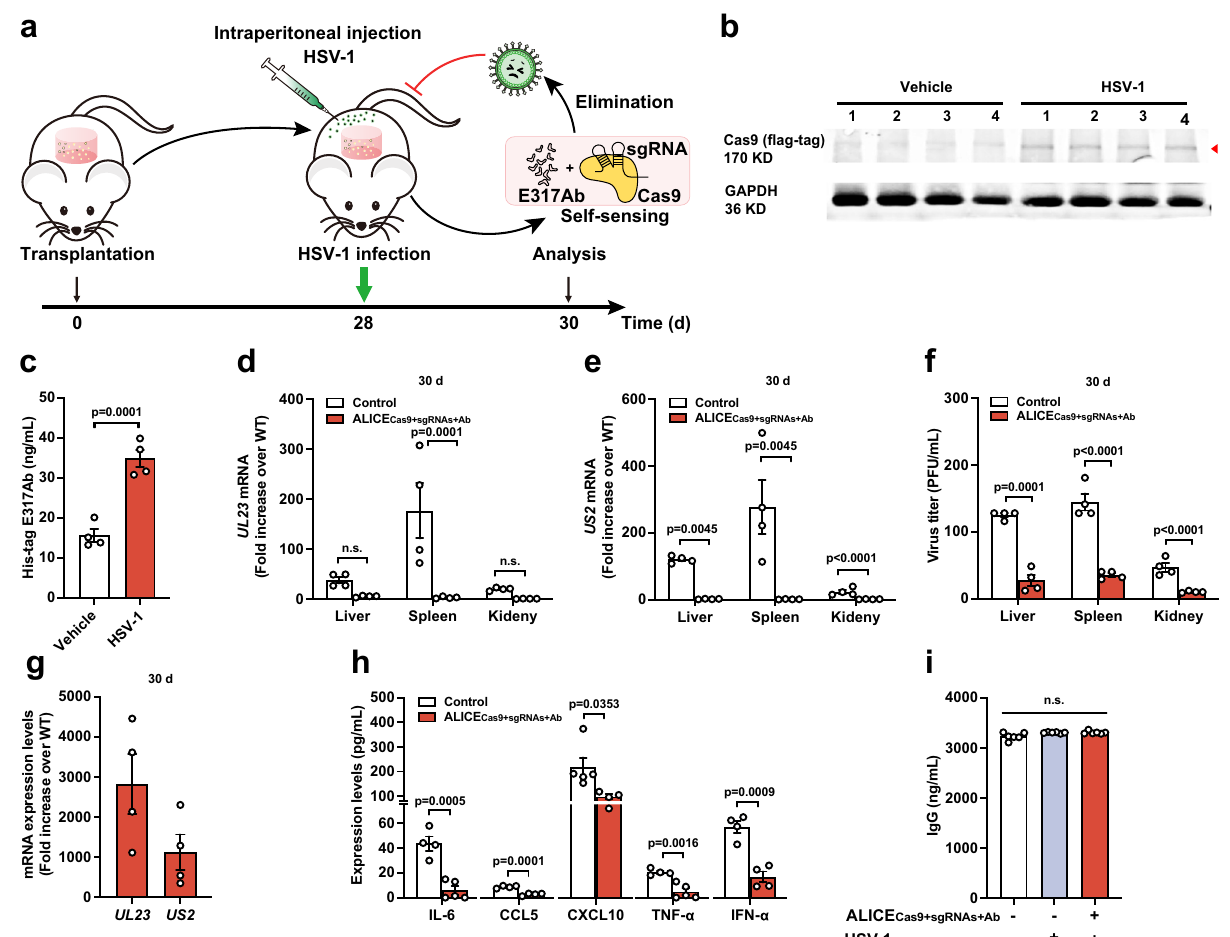
Fig. 5 | Long-term sense-and-destroy against HSV-1 mediated by ALICE Cas9+sgRNAs+Ab inmice.a SchematicillustrationofALICE Cas9+sgRNAs+Ab system for autonomous sense-and-destroy against HSV-1 in mice. HEK-293T cells stably integrated with ALICE Cas9+sgRNAs+Ab (HEK ALICE-Cas9-sgRNAs-E317Ab cells) or pcDNA3.1- transgenic HEK-293T cells (Control) were encapsulated into hydrogel-based scaf- folds and transplanted into mice abdomens via intraperitoneal surgery. At 28 d post-transplantation, HSV-1 (2×10 7 PFU) was intraperitoneally injected into each mouse. The antiviral effects of the ALICE Cas9+sgRNAs+Ab in mice was evaluated by detectingresidualviraltitersintheindicatedorgans(liver,spleen,kidney)at2days postHSV-1infection. b Westernblotanalysisof HSV-1-inducibleCas9expressionin hydrogel-based scaffolds. The red arrowhead indicates the expected Cas9 band. Number 1 – 4 represents four independent samples. c Validation of HSV-1-inducible E317Ab expression in mice. The E317Ab level in the bloodstream from ALICE Cas9+sgRNAs+Ab -treated mice, infected with or without HSV-1, was quanti fi ed at 30days post-transplantation. d , e qPCRanalysis of HSV-1 UL23 / US2 mRNA levelsin